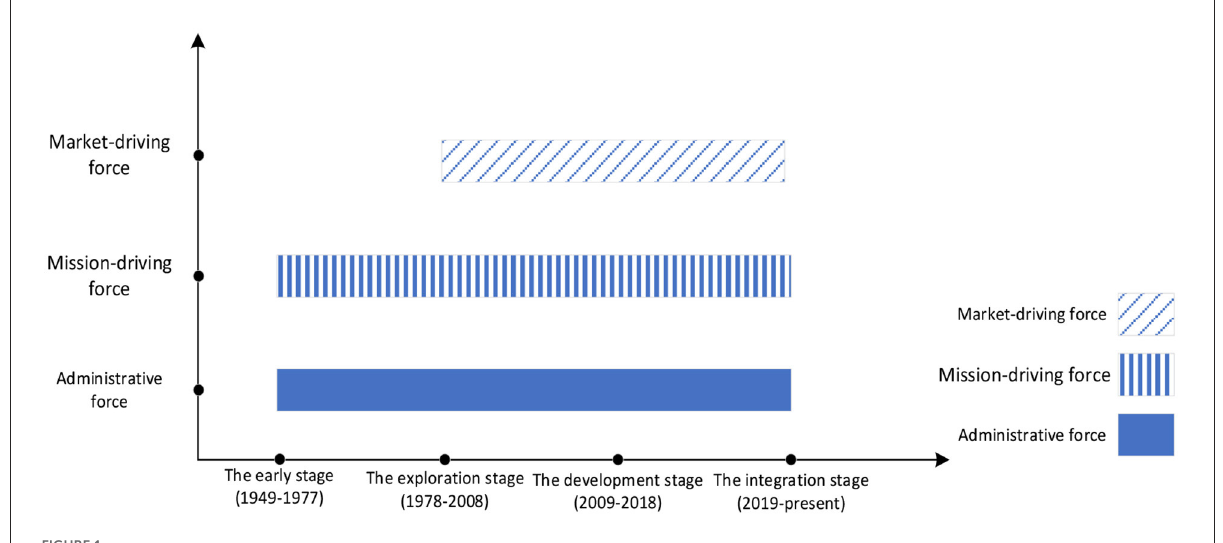
FIGURE1 Analysis framework of historical changes in performance appraisal of public hospitals in